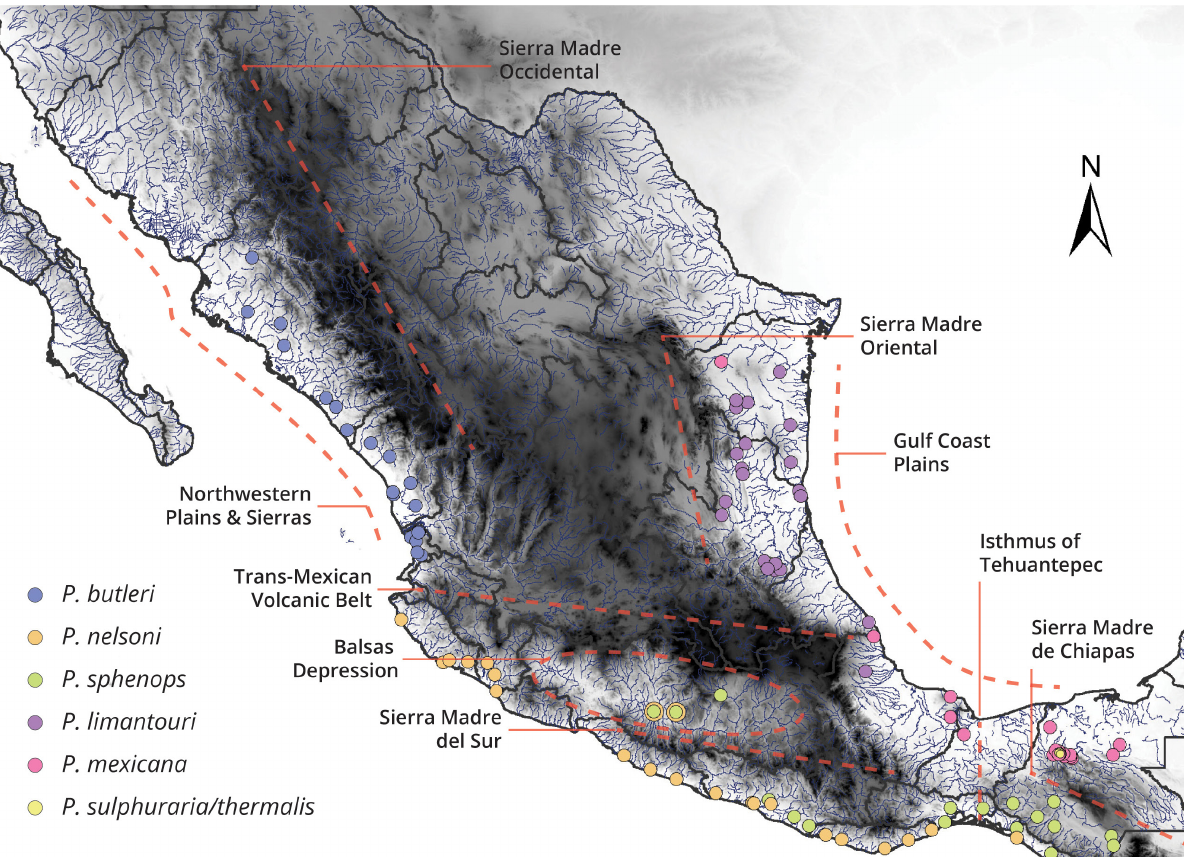
FIGURE 1 | Sampling localities of species in the subgenus Mollienesia in Mexico and the main physiographic barriers throughout the country. The main physiographic barriers in Mexico from north to south are Northwestern Plains and Sierras, Sierra Madre Occidental, Sierra Madre Oriental, Gulf Coast Plain, Trans Mexican Volcanic Belt, Balsas Depression, Sierra Madre del Sur, Isthmus of Tehuantepec, and Sierra Madre de